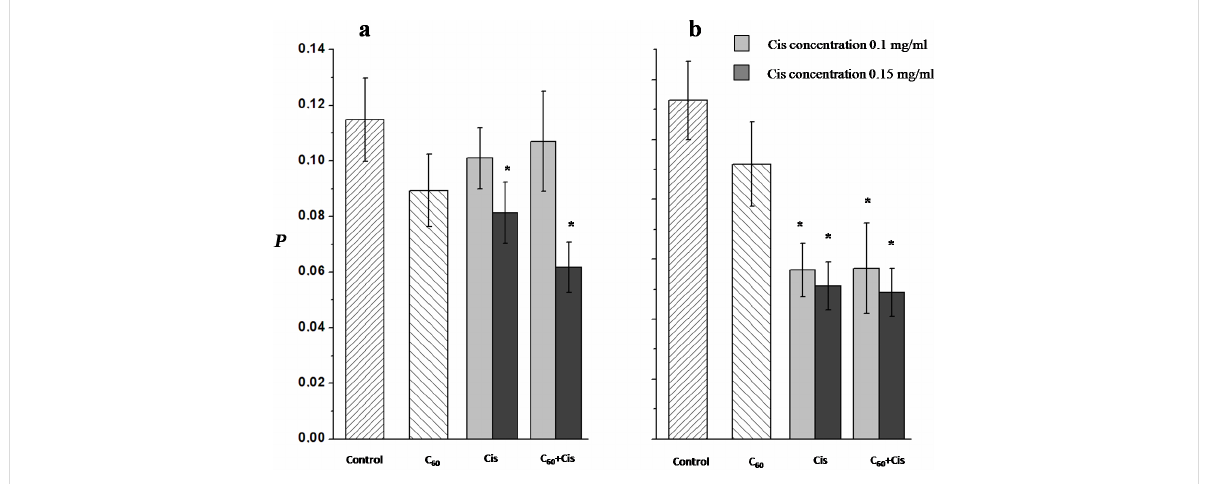
Figure 5: The relative amount of DNA in the comet tails ( P ) after 20 min of electrophoresis of a) lymphocytes and b) lymphoblasts treated with Cis, C 60 fullerene or C 60 +Cis nanocomplex. Control: cells were incubated in RPMI 1640 medium without any additional agents. The average values of 5–7 independent experiments are presented. The error bars represent the standard deviations. *Statistically significant ( p < 0.05) with respect to control cells.